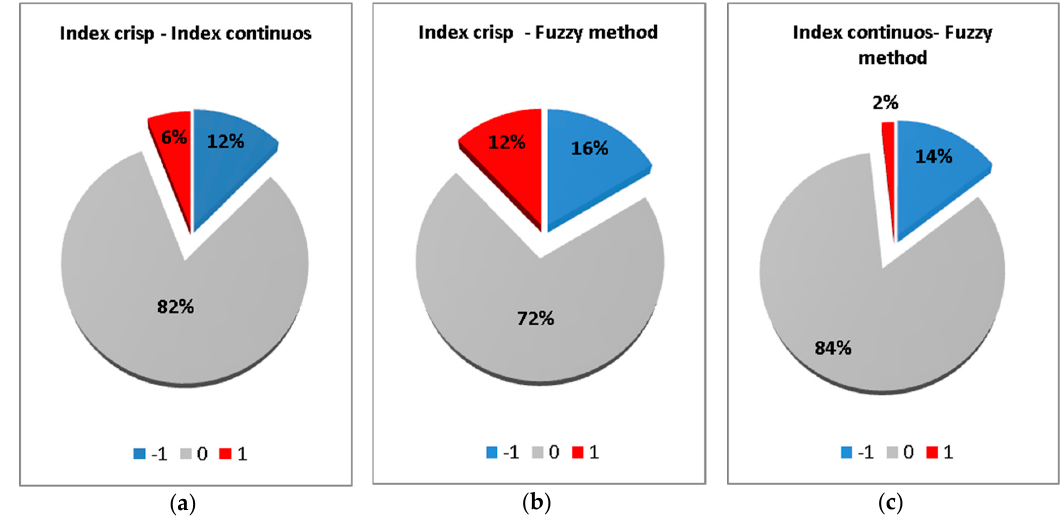
Figure 6. Graph showing the number of buildings with assigned single vulnerability indices of 1, 2, 3, Index method, the results are closer to the Fuzzy logic method results. 4, or 5, calculated by the three methods.